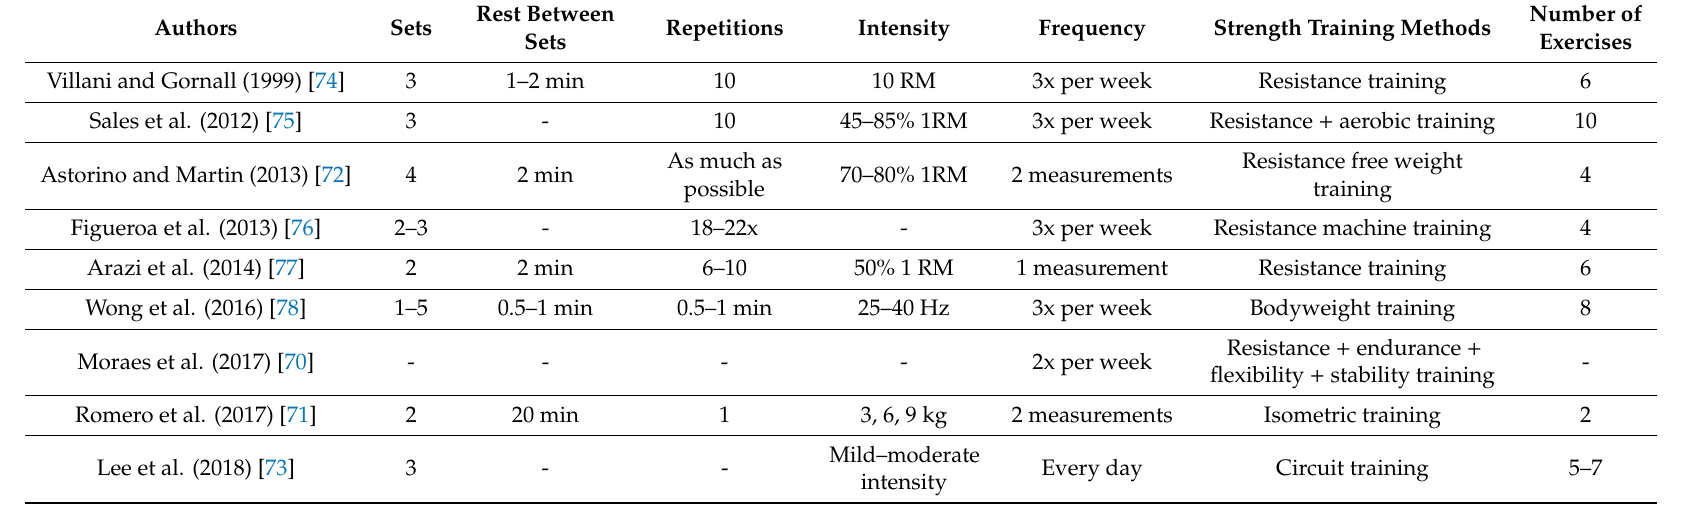
Table 2. Strength training parameters and methods in each